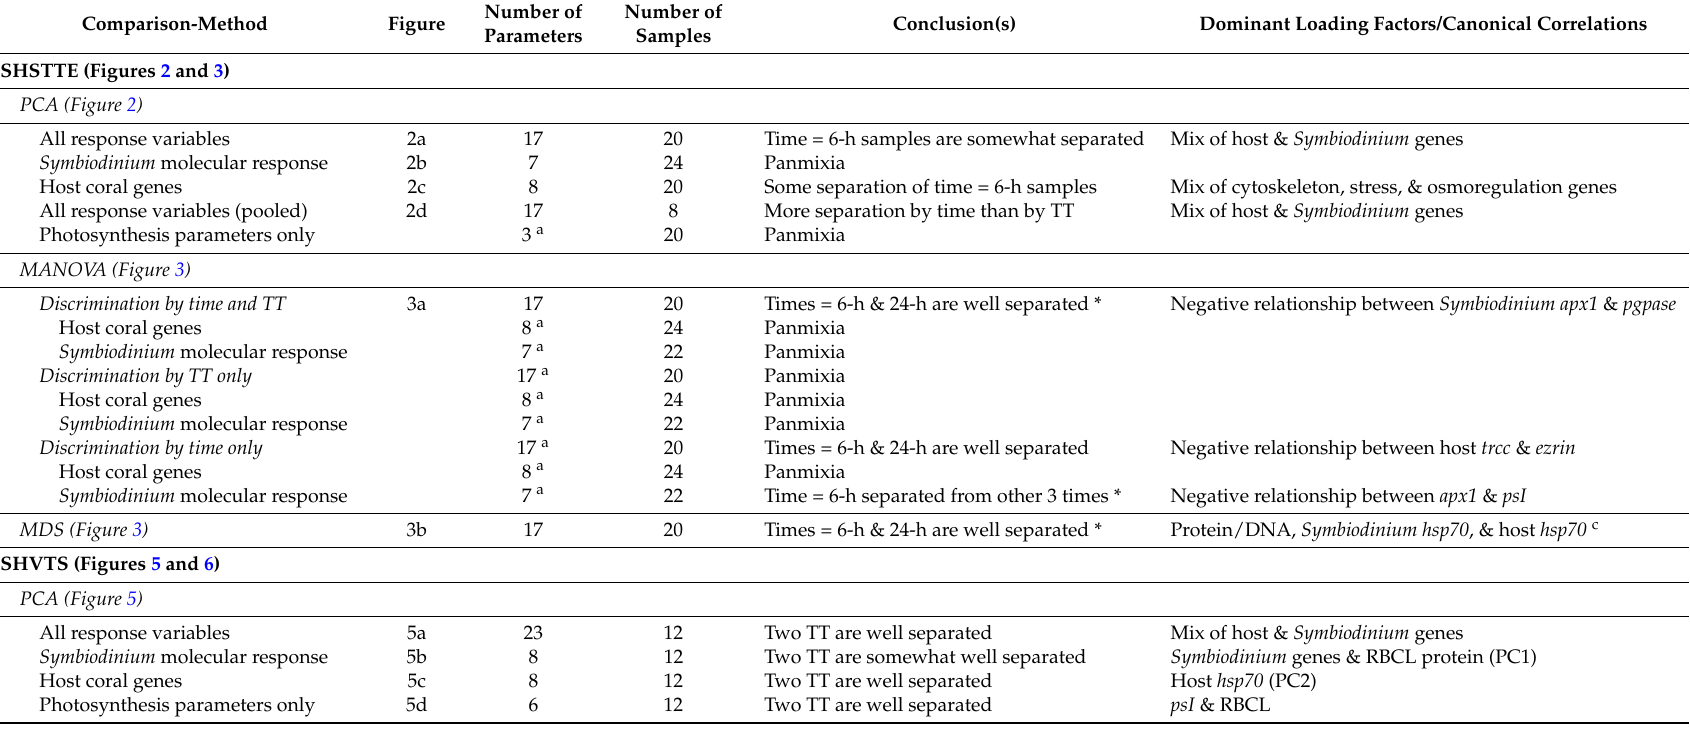
Table 2. Summary of comparisons and major findings. Dominant loading factors (principal components analysis (PCA)) and canonical correlations (multivariate analysis of variance (MANOVA)) were only included in the right-most column when the respective technique resulted in good partitioning of the data. “ Symbiodinium molecular response” included the genome copy proportion (GCP) + 6 mRNAs for all comparisons except for PCA of the S. hystrix variable temperature study (SHVTS), in which case the ribulose-1,5-bisphosphate carboxylase/oxygenase large subunit (RBCL) protein was also included. In certain cases, Wilks’ lambda or comparable MANOVA-based statistics could not be calculated due to having a large number of response variables relative to observations. Only when the Symbiodinium data were included could temporal partitioning (i.e., “discrimination”) be achieved in the S. hystrix short-term temperature experiment (SHSTTE); in contrast, data from the eight host coral genes were required to separate samples by temperature treatment (TT) and site of origin (SO) × TT in the SHVTS. PCA eigenvectors and eigenvalues can be found in online supplemental data file 2. * statistically significant observation. When p -values approached significance ( α = 0.05), the exact values have been included. HBH = Houbihu. HWN = Houwan. stab = stable. var =